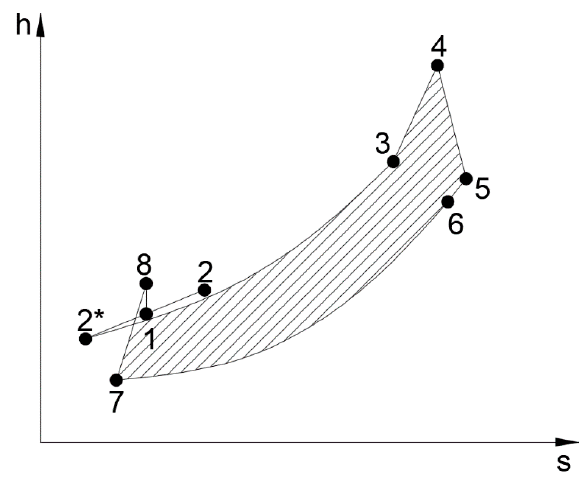
Figure 5. Cycle of the unit in h-s coordinates.